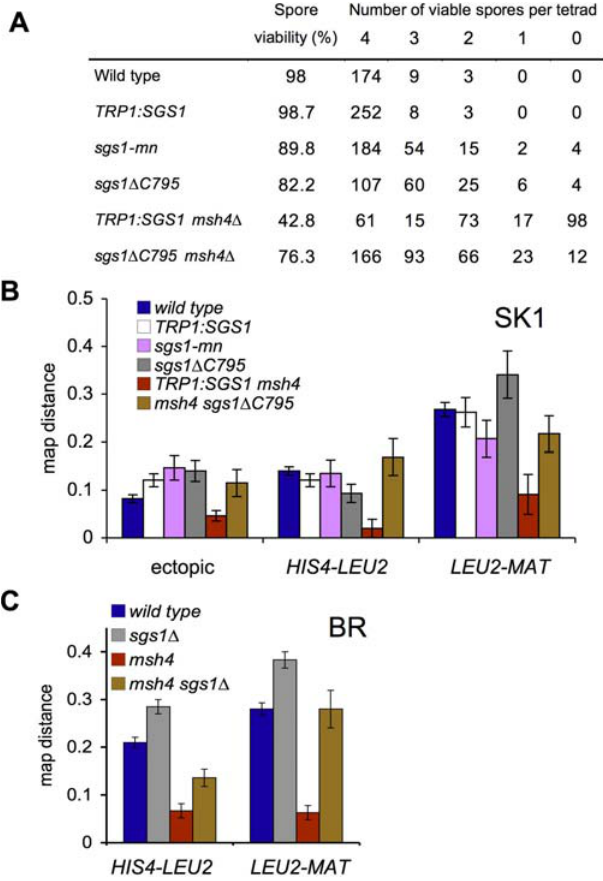
Figure 2. Loss of Full Sgs1 Activity Restores Spore Viability and Crossing Over to zmm Mutants (A) Overall spore viability and patterns of spore lethality in tetrads from SK1 strains. (B) Map distance (cM; error bars denote standard error of map distance) in three intervals on Chromosome III in SK1 (see Figure 1B and 1C for details). Values for wild-type are from [16]. (C) Map distance in two allelic intervals on Chromosome III in BR strains. Values for wild-type and sgs1 D are from [32]. DOI: wild-type strains show similar spore viability ( (cid:1) 98%; see also Figure 2A) and resistance to methyl methane sulfonate (unpublished data). Both sgs1 D C795 and sgs1-mn show reduced